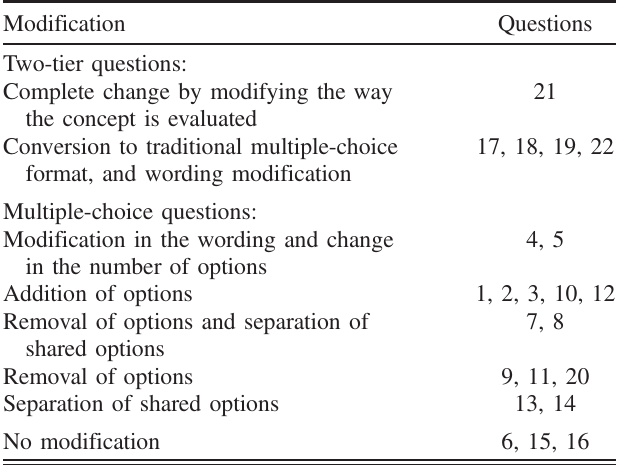
TABLE II. Overview of the modifications made in the modified version of the